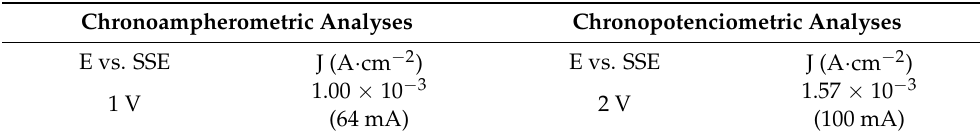
Table 3. Comparison of the chronoampherometric and chronopotenciometric behavior of EBHSS.